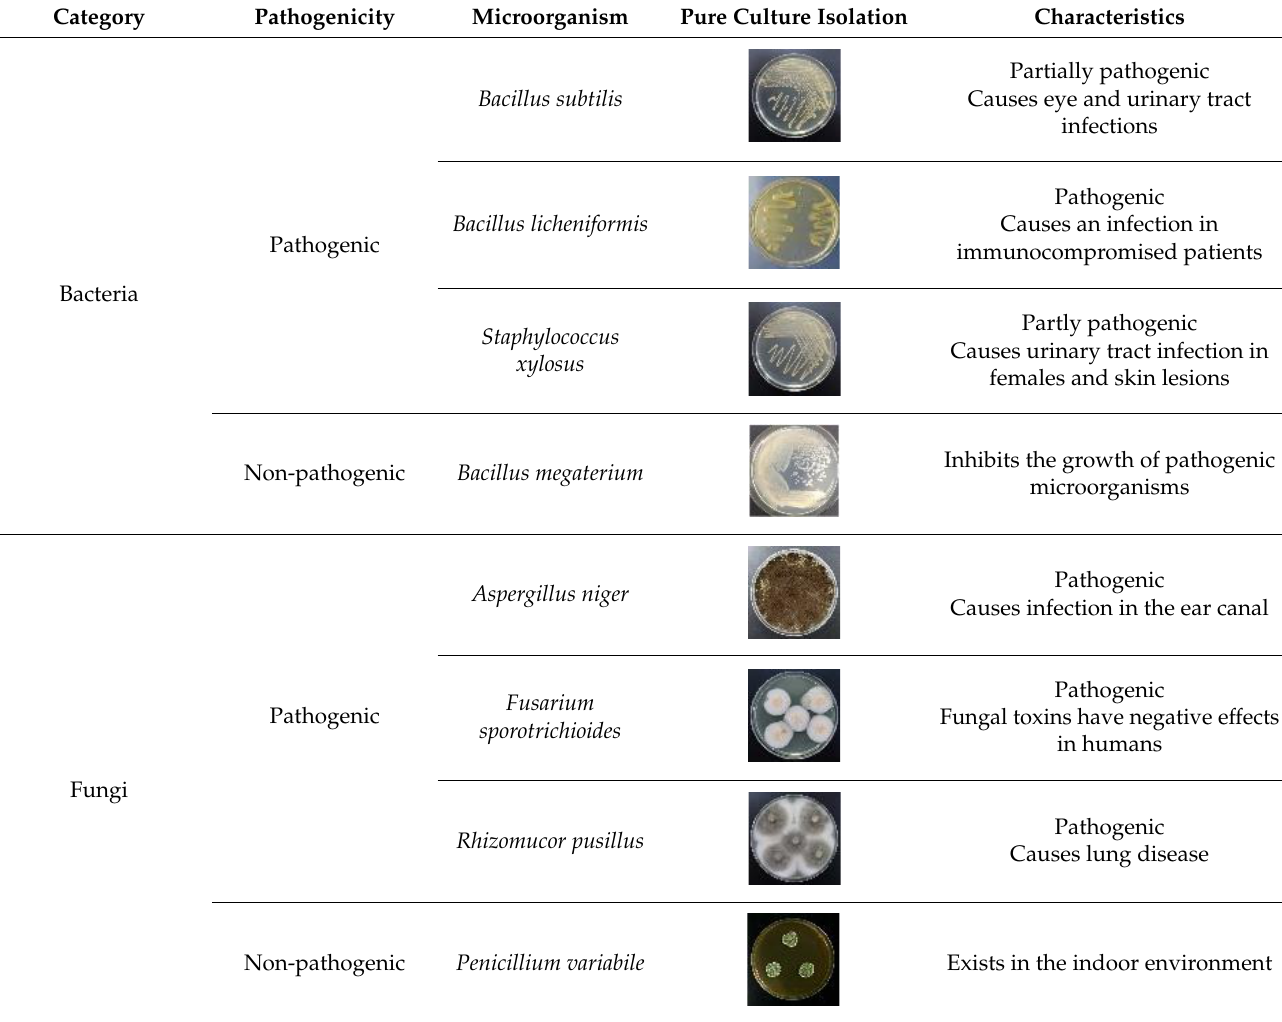
Table 5. Airborne microbial species with detection frequencies of ≥50%.